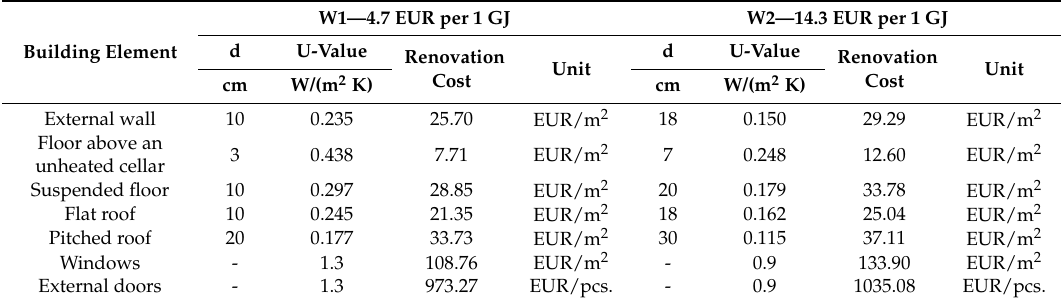
Table 14. The cost-optimum renovation variants (depending on the energy price) of building’s envelope—discount rate changed to